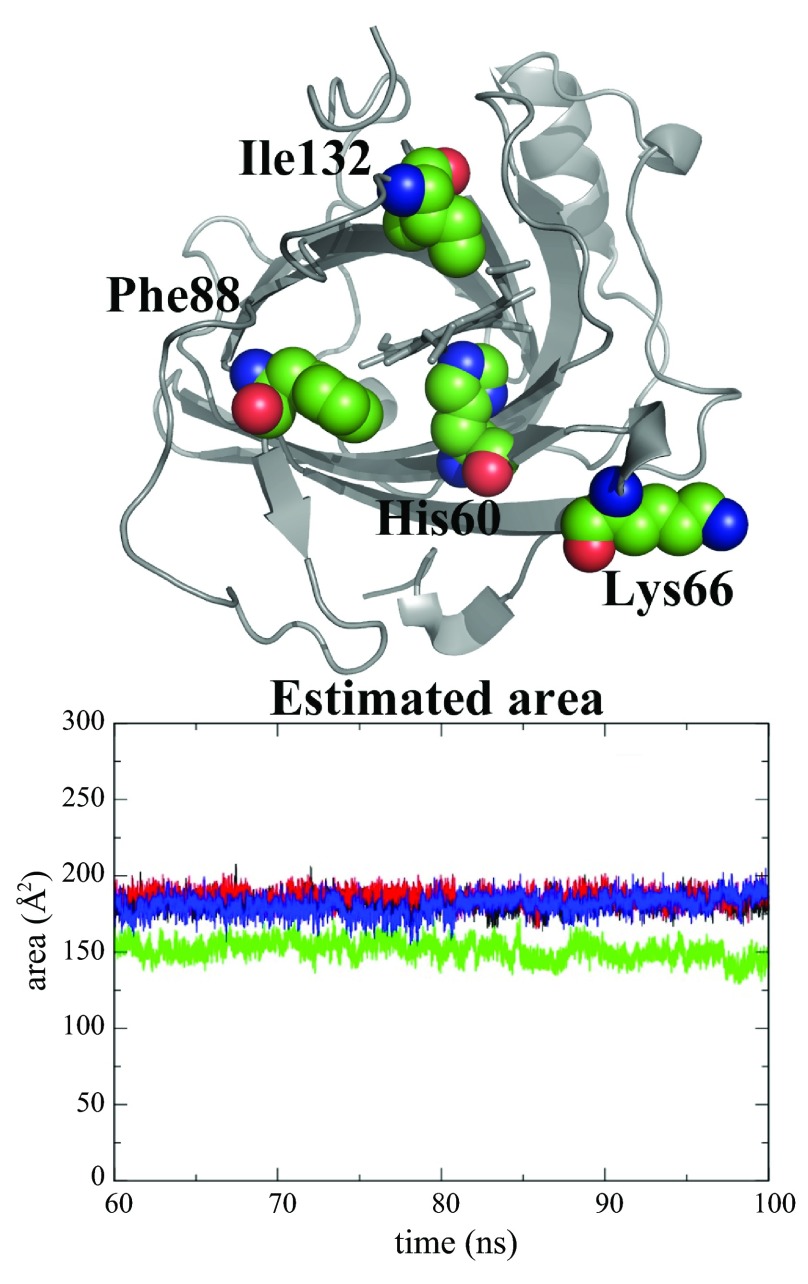
Time (ns) evolution of the estimated area (Å
2) of the heme cavity mouth determined from the triangles defined by the Cα atoms of residues His60, Lys66, Phe88 and Ile132.Wild type NP7 in open and closed states is shown as red and black lines; Δ(1-3) variant in open and closed states is shown as blue and green lines.